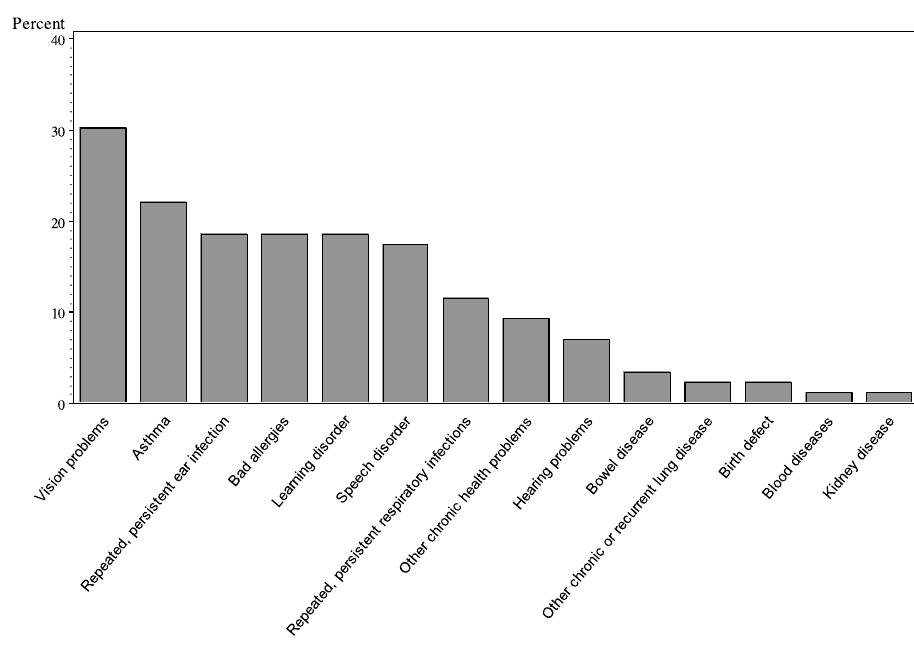
Figure 1. Frequencies of Health Problems ( n = 86).